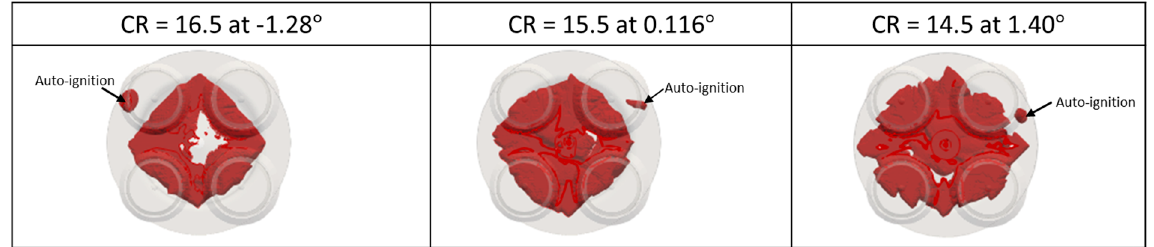
Figure 8. Comparison of: ( a ) combustion duration; and ( b ) in-cylinder average temperature for λ = 2.85 and ST = − 5 CAD at different CRs.